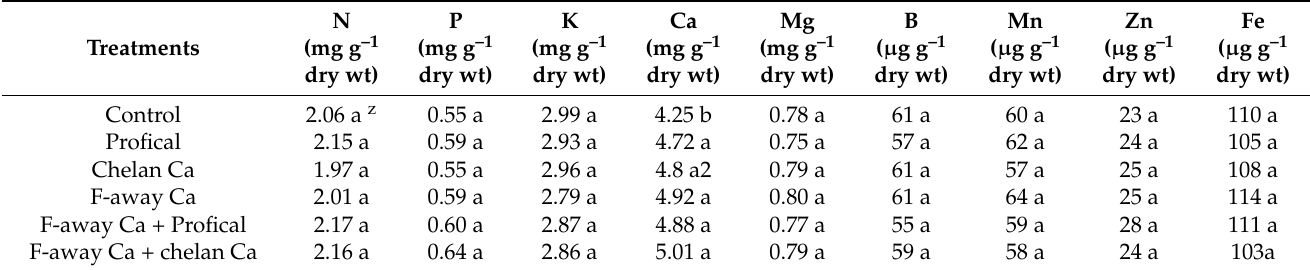
F-away Ca + Profical F-away Ca + Chelan Ca